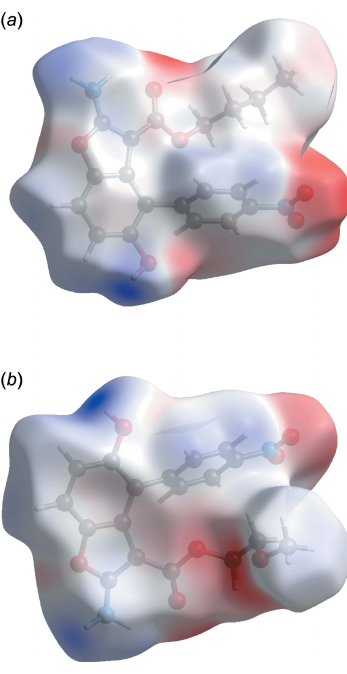
Figure 9 Hirshfeld surface mapped over the electrostatic potential energy for ( a ) the major disorder component of BF1 and ( b )